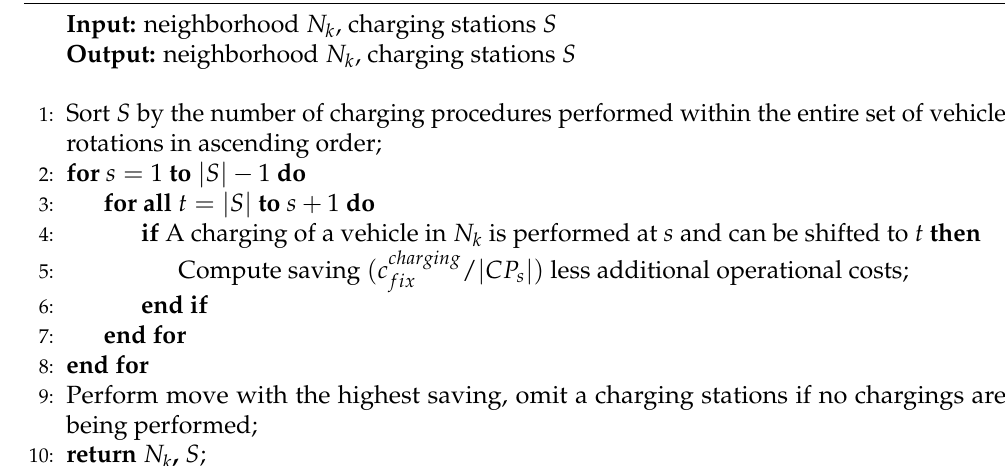
chargings are no longer being performed at a specific stop point. Algorithm 8 Shift Charging Procedures ( SCP